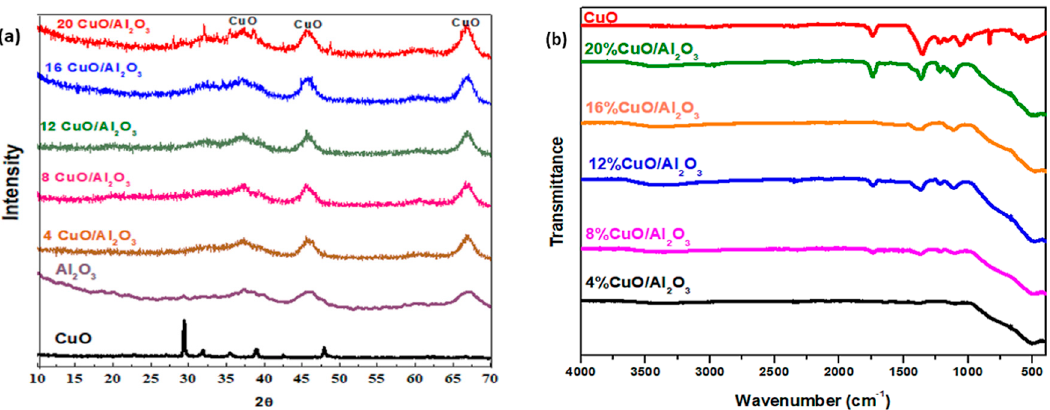
Figure 2. X-ray diffraction patterns ( a ) and Fourier-transform infrared (FTIR) spectra ( b ) of pure γ -Al 2 O 3 and CuO/Al 2 O 3 nanomaterials.